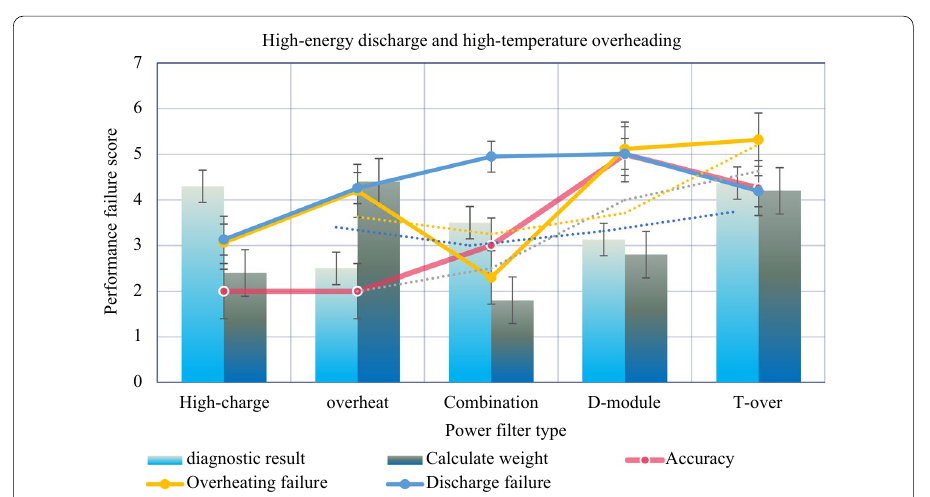
Fig. 14 High-energy discharge and high-temperature